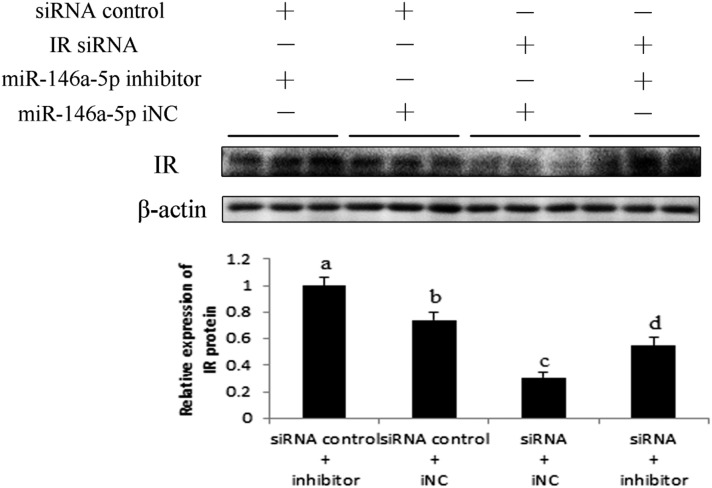
Western blot analysis of IR siRNA transfection. Preadipocytes were transfected with miR-146a-5p inhibitor/iNC and IR siRNA/siRNA control, and IR protein was assayed on induction day 8. Panels with different letters were considered statistically significant (P < 0.05, n = 3).